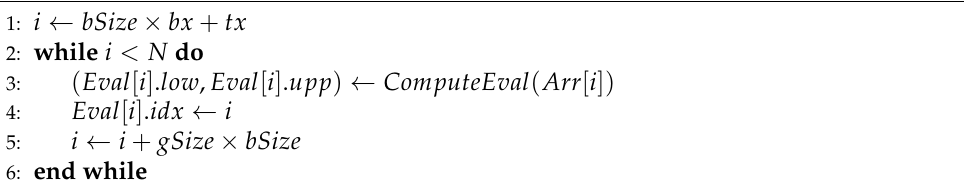
Algorithm 2 Computing an array of floating-point interval evaluations